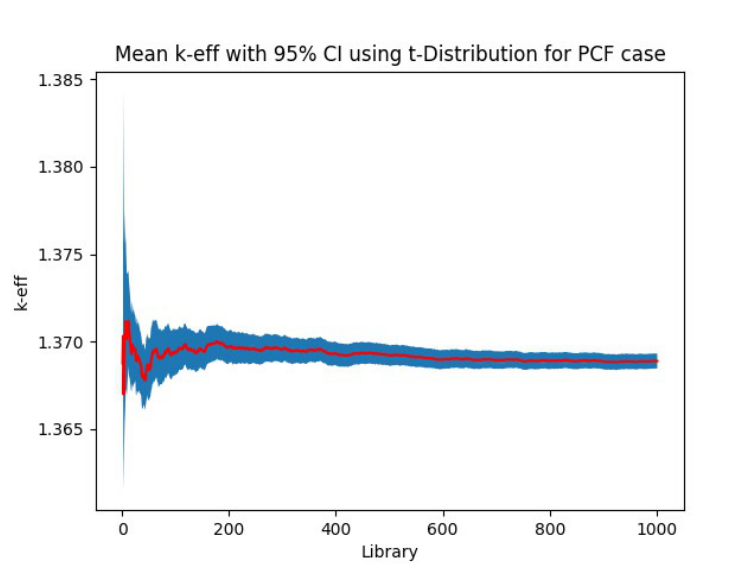
Figure 3. Confidence Intervals for Mean k-eff for PWR Colorset at HFP (PCF).